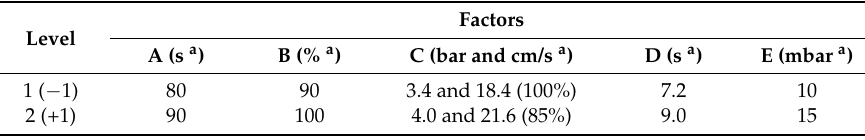
Table 1. Factors and levels selected for the main